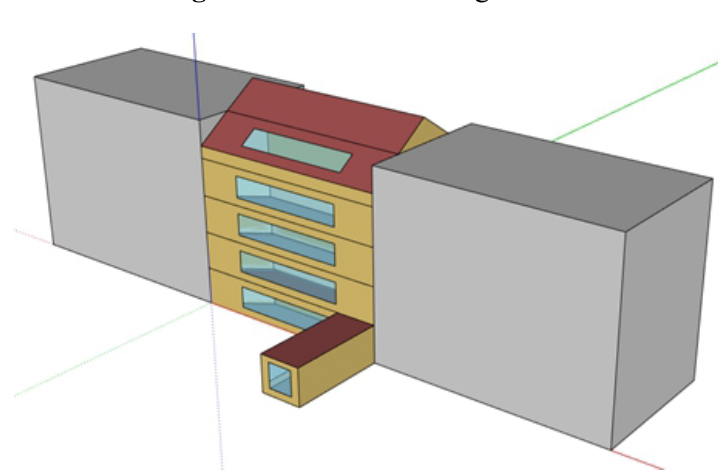
Figure 4. Testbed building